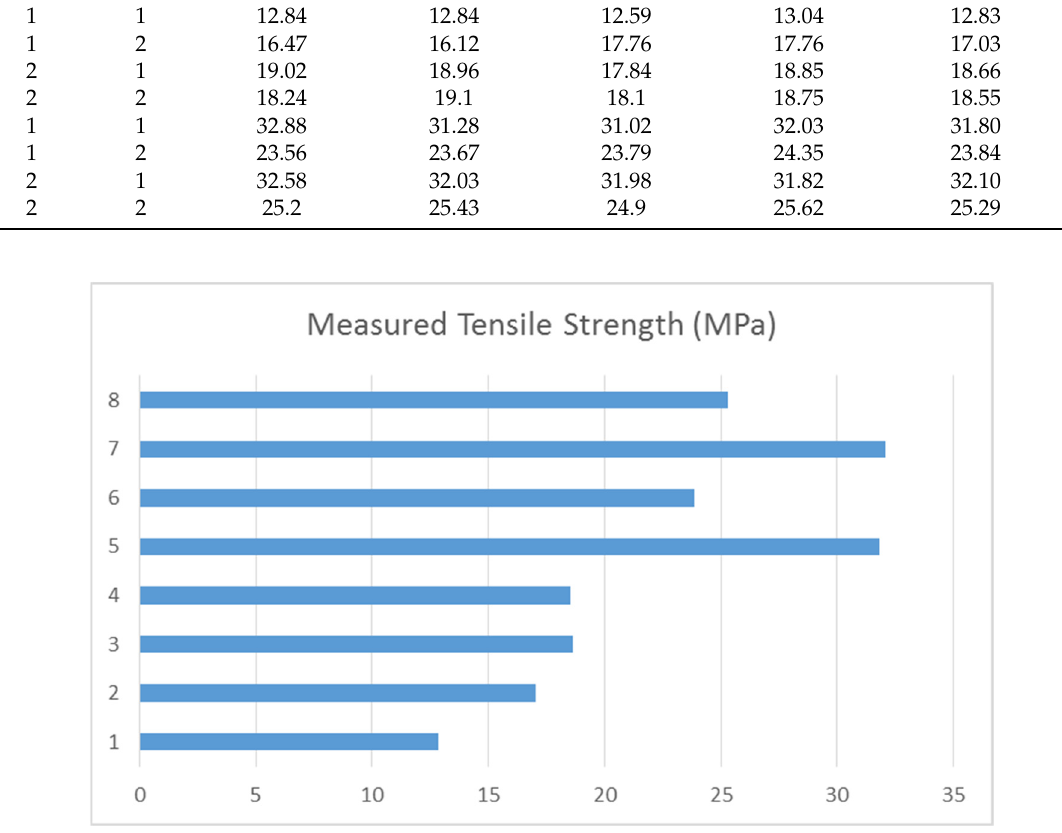
Figure 6. Presentation of measured tensile strength for each experiment.